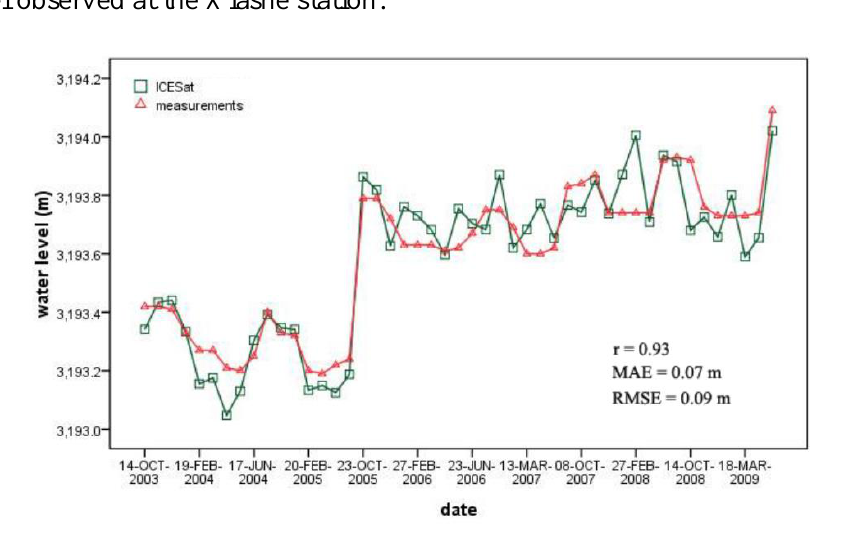
Figure 3. Time series of water levels retrieved from ICESat versus measurements. The green square represents the water level estimated by ICESat, and the red triangle represents the water level observed at the Xiashe station.